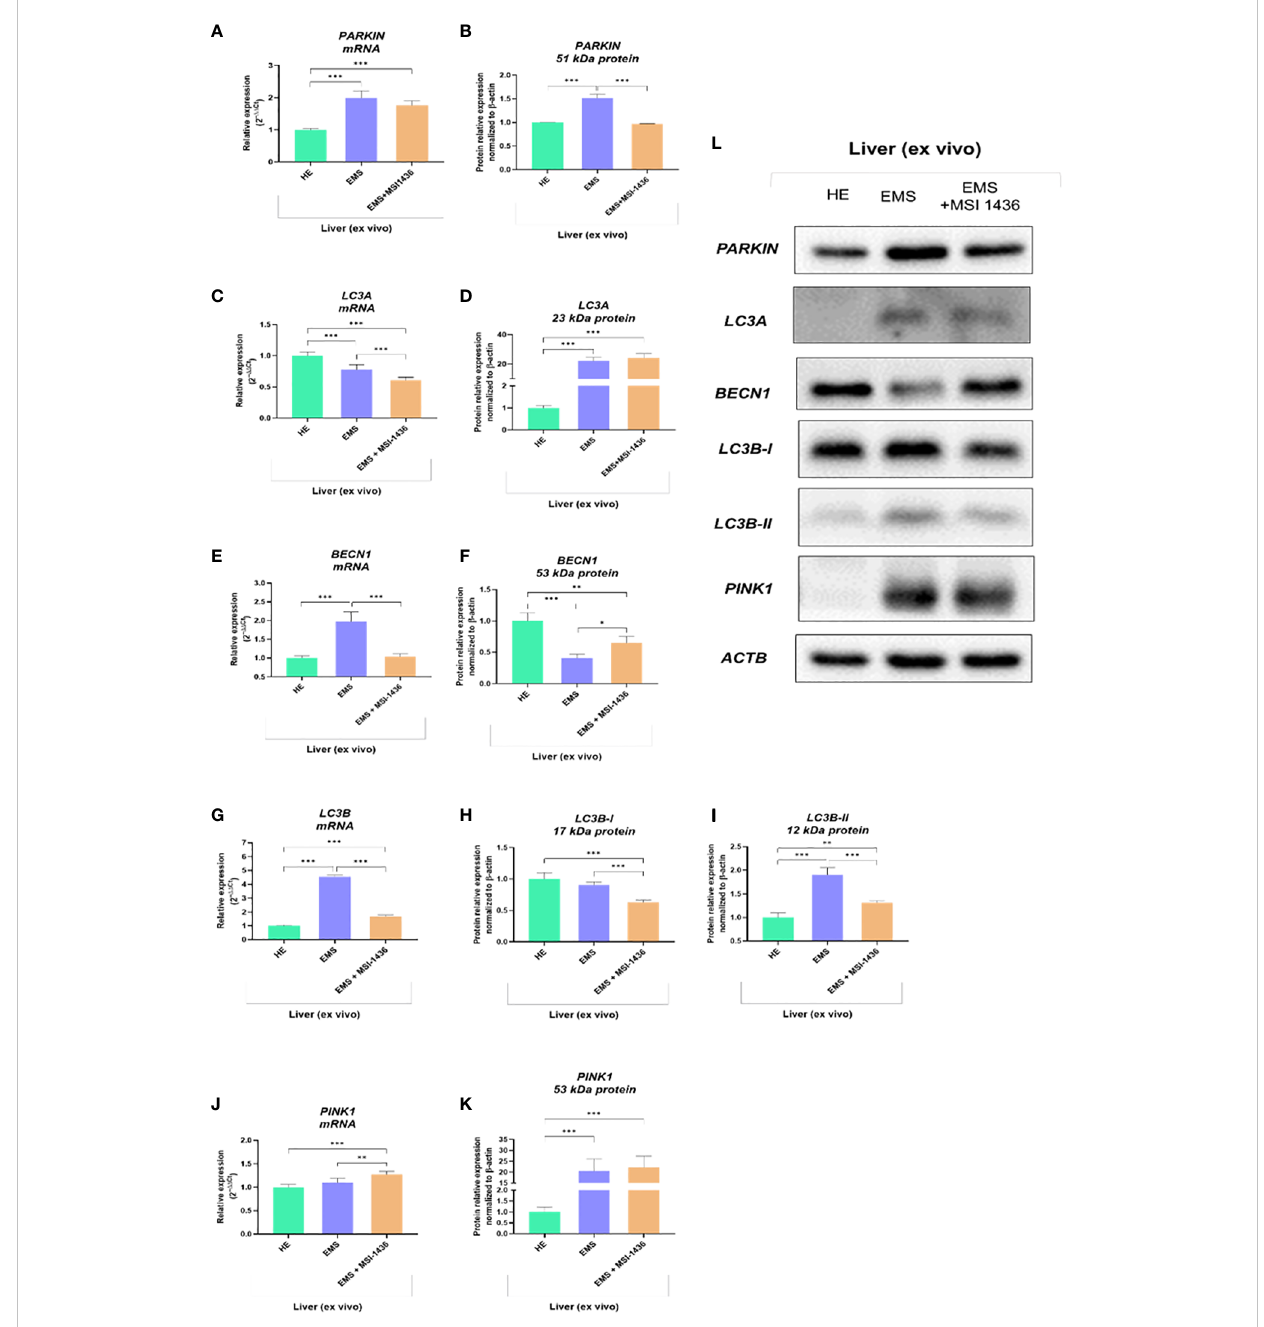
FIGURE 3 The expression of autophagy-related transcripts and proteins. The tested pro fi le included evaluation of PARKIN1 (A, B, L) , LC3A (C, D, L) , BECN1 (E, F, L) , LC3B (G-I, L) and PINK1 (J-L) . Data are presented as a mean value obtained from measurments ± SD. Statistical signi fi cance was marked as follows: *p- value < 0.05, **p-value < 0.01 and ***p-value <